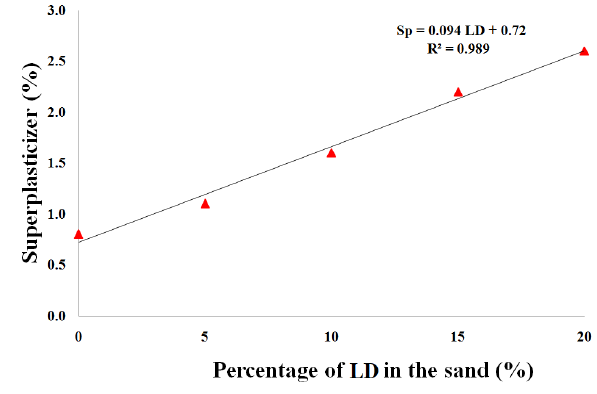
Figure 12: Dosage of superplasticizer required for concrete to achieve the target slump